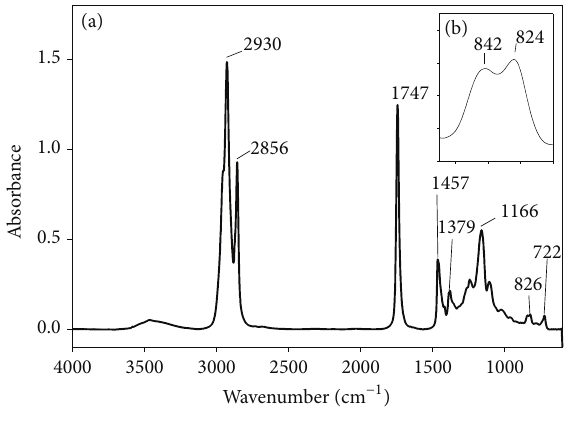
Figure 3: 2nd derivative of the FT-IR spectrum of milkweed polyformyl